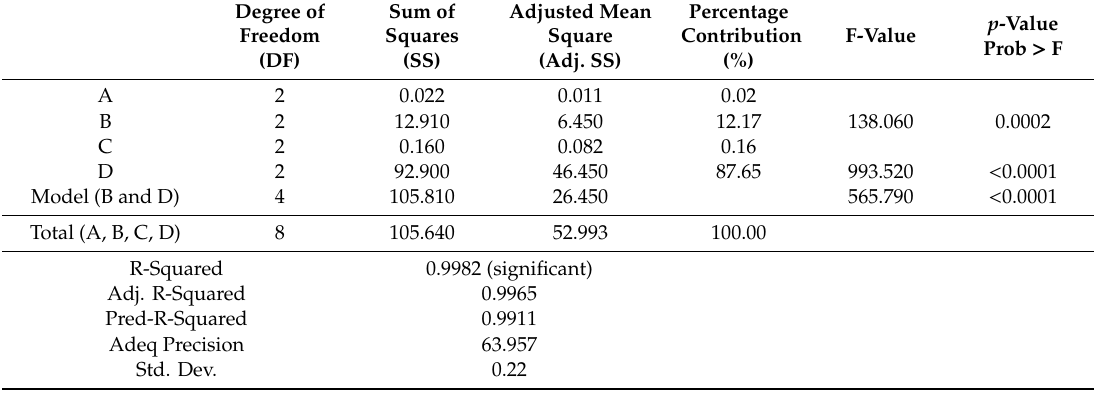
Table 3. Summary of ANOVA for selected factorial model.